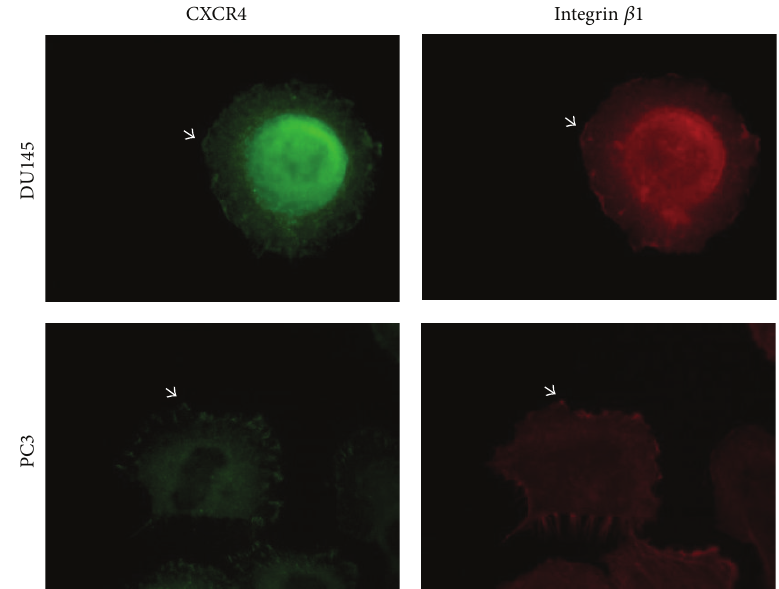
Figure 5: CXCR4 and integrin 𝛽 1 are located closely at focal contact sites. PC3 and DU145 cells were incubated for 2 hrs, fixed, and double- stained for CXCR4 and 𝛽 1 integrin. Arrows in the images indicate the localization of both CXCR4 with 𝛽 1 integrin in focal contacts.